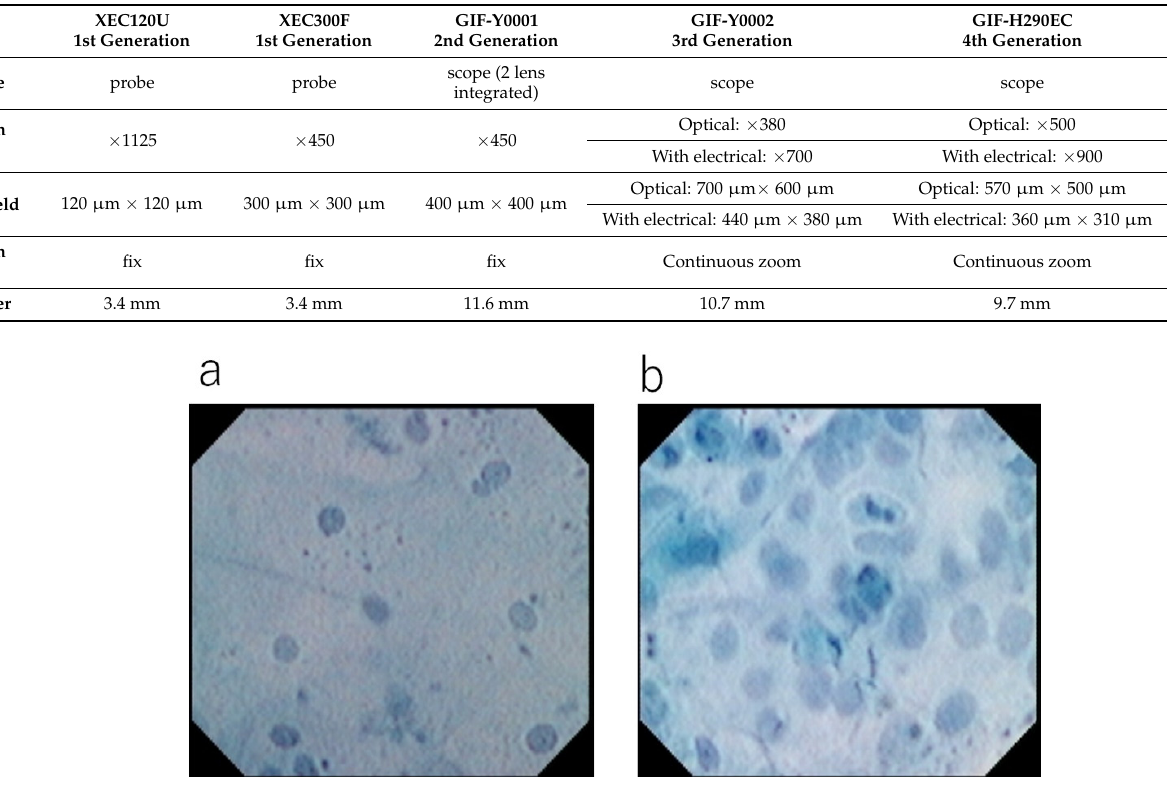
Table 1. Four generations of endocytoscope.